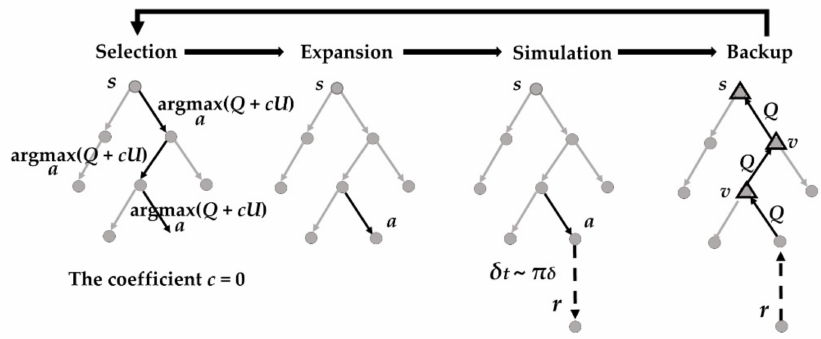
Figure 1. The tree search used in the previous work